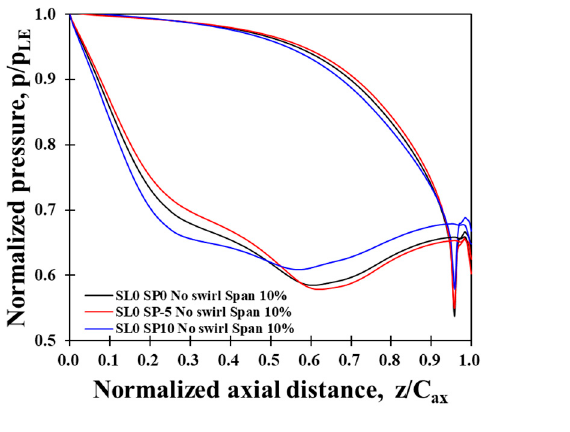
Figure 14. Comparison of NGV loading due to the compound lean angle: ( a ) Span height 10%; ( b ) Span height 90%.